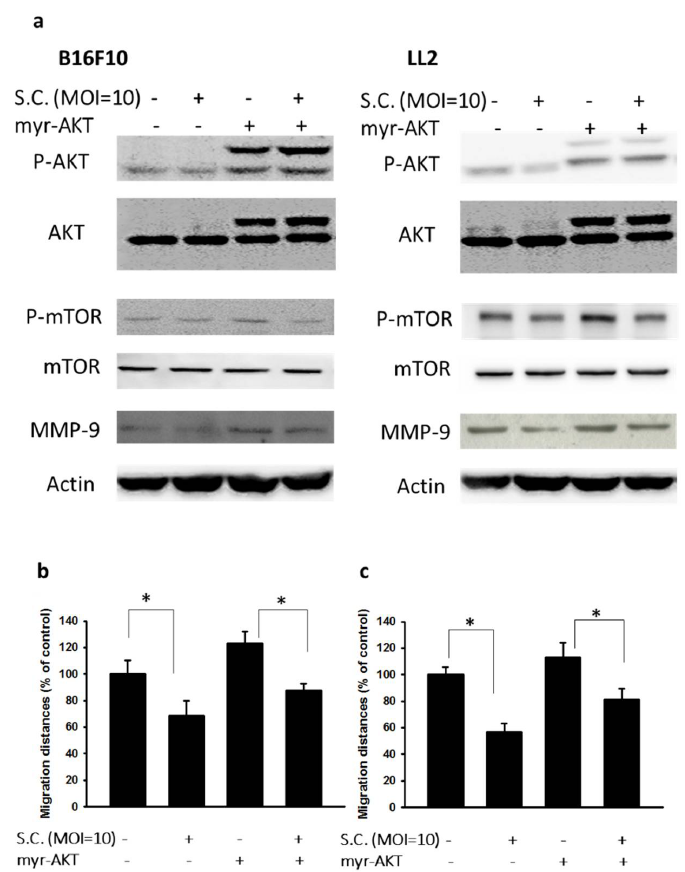
Figure 3. Constitutively active- Phosph-Protein Kinase B (P-AKT) reduced Salmonella (S.C.)-induced decrease of MMP-9. The B16F10 and LL2 cells were transfected with constitutively active AKT plasmids for 16 h prior to 4 h Salmonella treatment. ( a ) The expression of phosphorylation AKT, AKT, phosphorylation Phosph-mammalian Targets Of Rapamycin (P-mTOR), mTOR, and MMP-9 protein in B16F10 and 4T1 cells was determined. The immunoblotting assay was repeated three times with similar results. The migration distances of B16F10 ( b ) and LL2 ( c ) cells were measured. ( n = 3, data are mean ± SD. * p < 0.05).